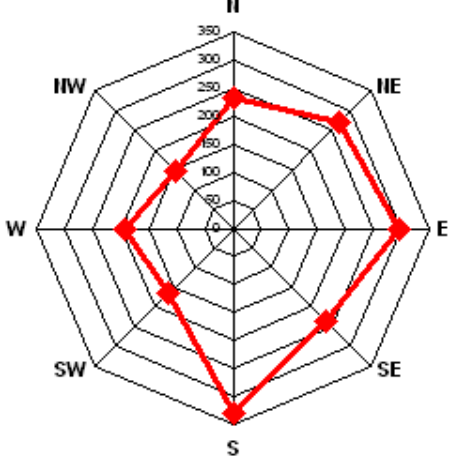
Figure 3: Number of days with each daily resultant wind direction data (Oct 21, 1996 through May 21, 2001) obtained at the Southern Regional Climate Center. Table 2: Mean daily change in lake level for eight resultant wind directions. The presented P values are the results of the one-way ANOVA comparing the water level changes for different wind directions.